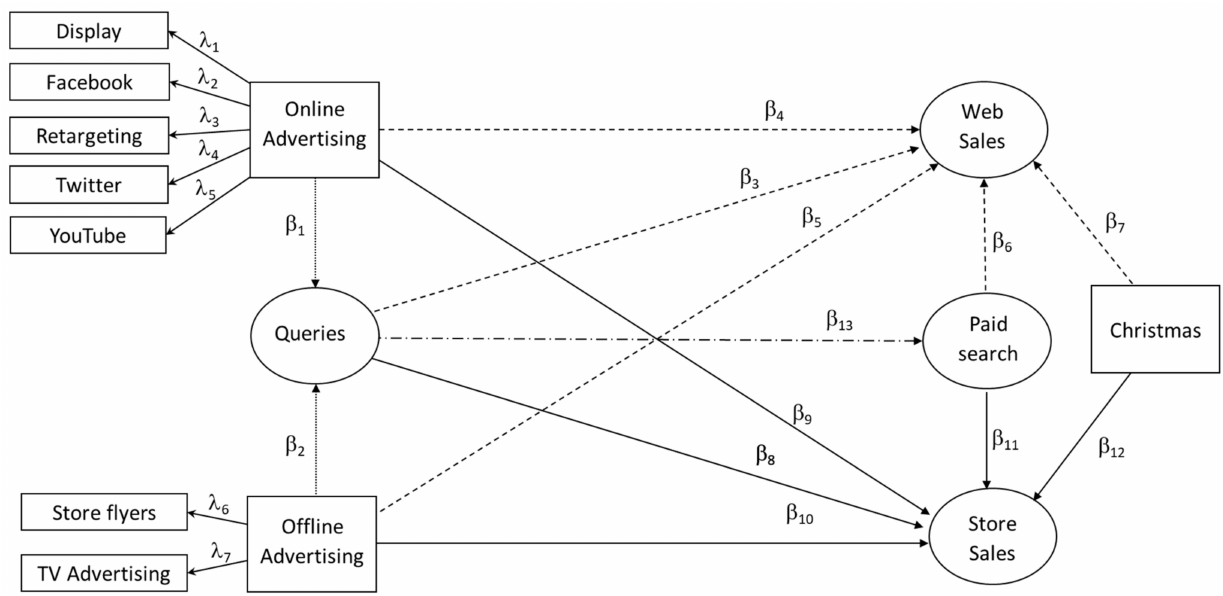
Figure 2. The PLS-SEM model used to illustrate the sample and meboot bootstrapping results comparison. Figure adapted with permission; the article was published in Journal of Business Research, 112, M é ndez-Su á rez, M.; Monfort, A. The amplifying effect of branded queries on advertising in multichannel retailing, 254–260, Copyright Elsevier